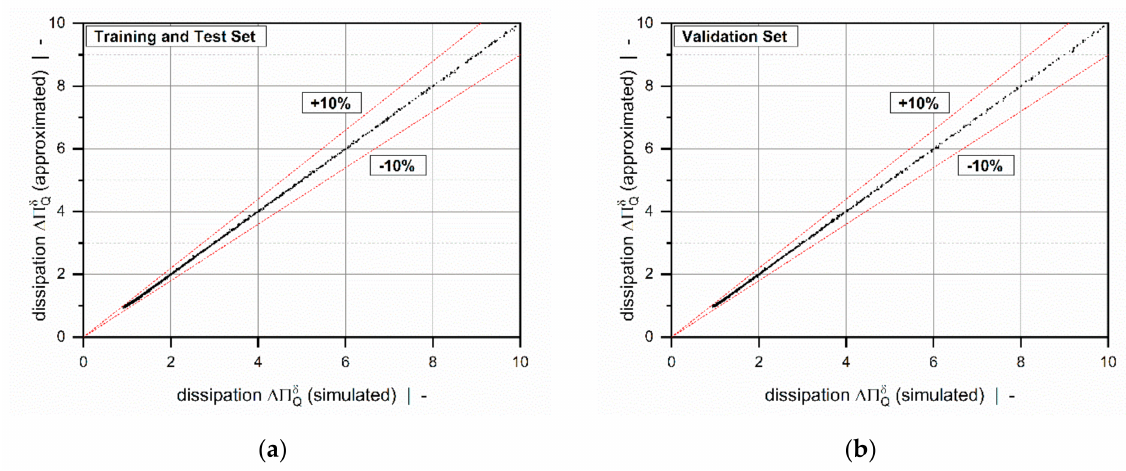
(cid:16) (cid:17) = f t / D b , n , Π δ : training and test set ( a ) and validation set ( b ). The dashed lines V Q